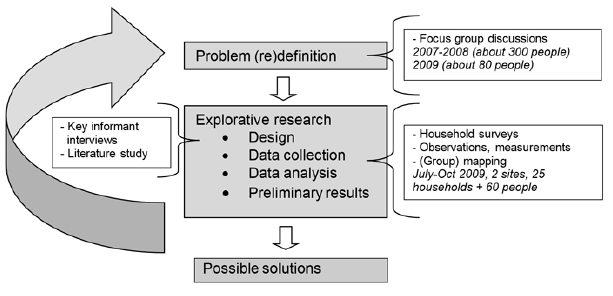
Fig. 1 . Diagram depicting the methodology used in